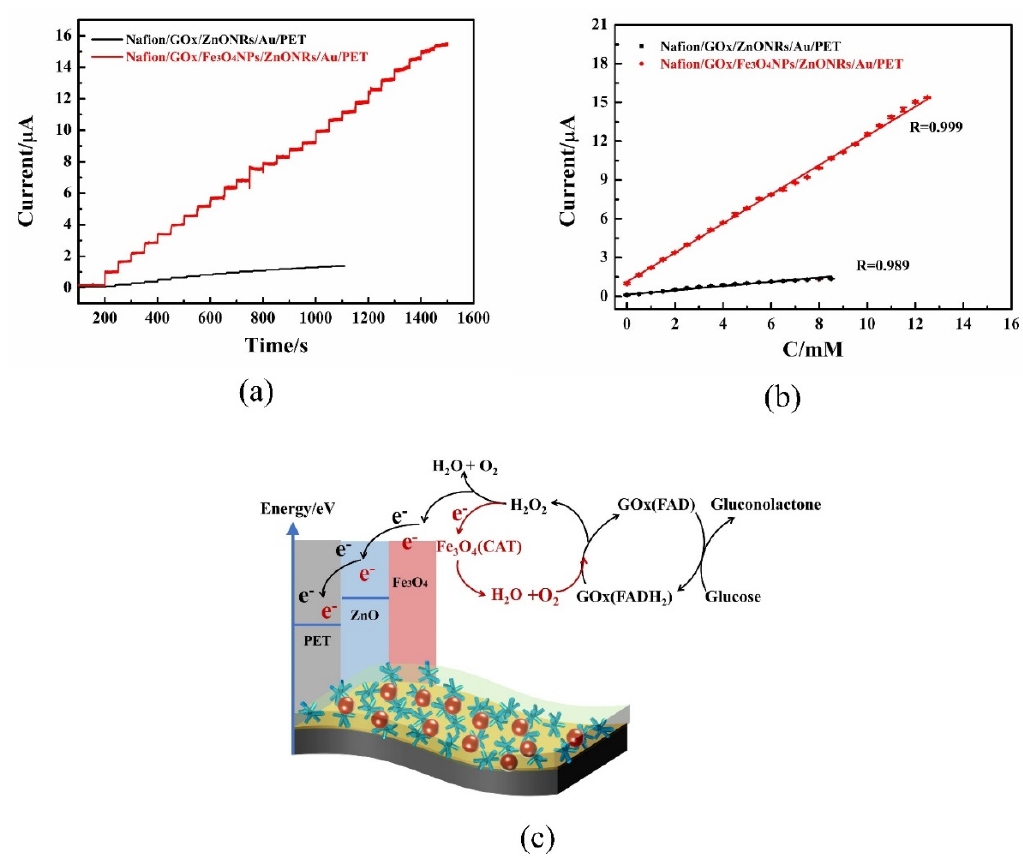
Figure 6. ( a ) The amperometric response of the as-fabricated glucose sensors for the successive addition of 100 µ L of glucose solution in 50 mL of PBS at an applied bias potential of +0.8 V. ( b ) The corresponding calibration plots of the as-fabricated glucose sensors. ( c ) The redox reaction mechanism and electron transport scheme on the as-fabricated enzymatic working electrode.